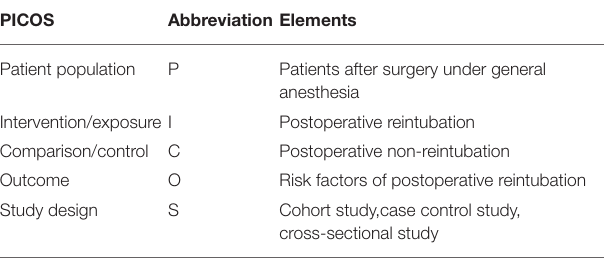
TABLE 1 | The PICO statement about